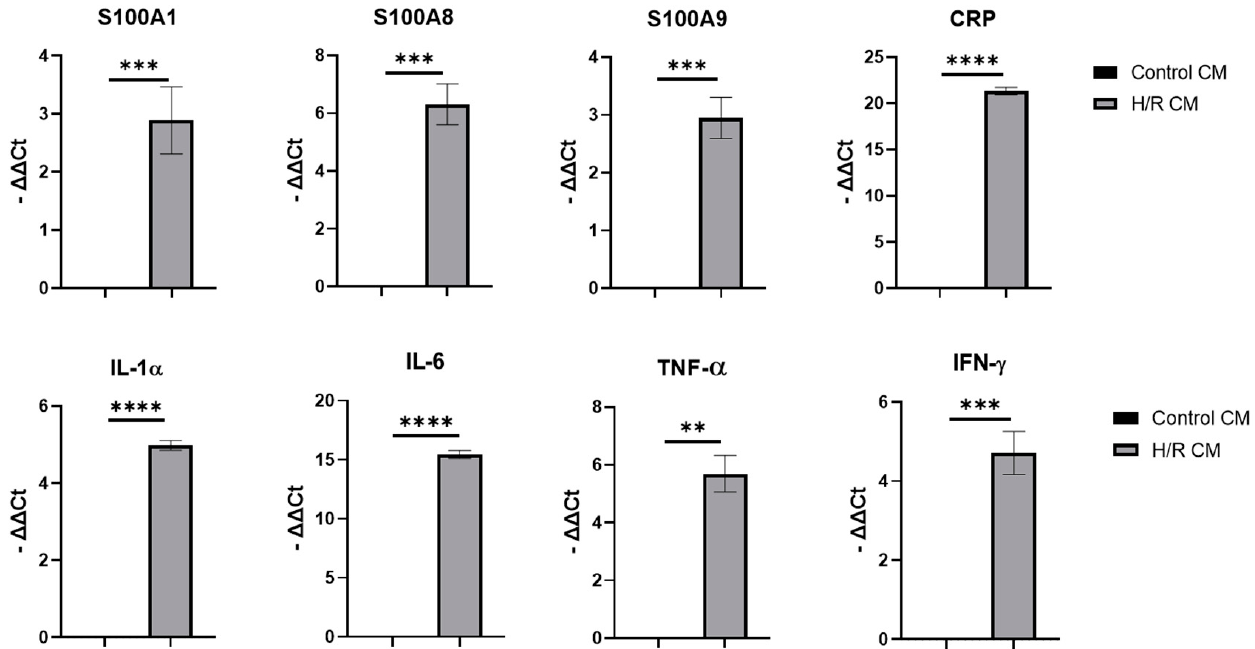
Figure 3. The comparison of expression levels of interested gene in hAMSCs with or without S100A8/A9 treatment. The significance among the groups was calculated using t test. * p < 0.05, ** p < 0.01, **** p < 0.0001.